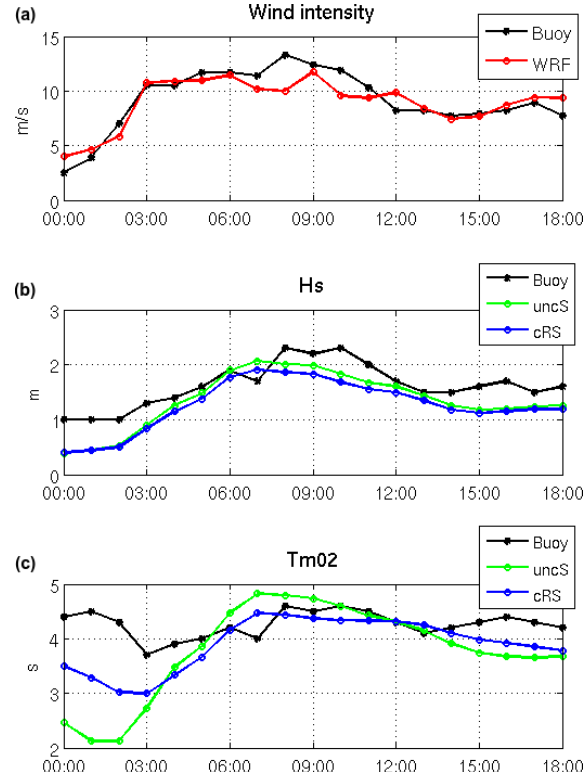
Figure 4. (a) Wind intensity, (b) Hs and (c) Tm 02 time series at DB during the wind-jet E3 event (25 April 2014). In black: the measured data; in red: the WRF model data; in green: the uncS run results; in blue: the cRS run